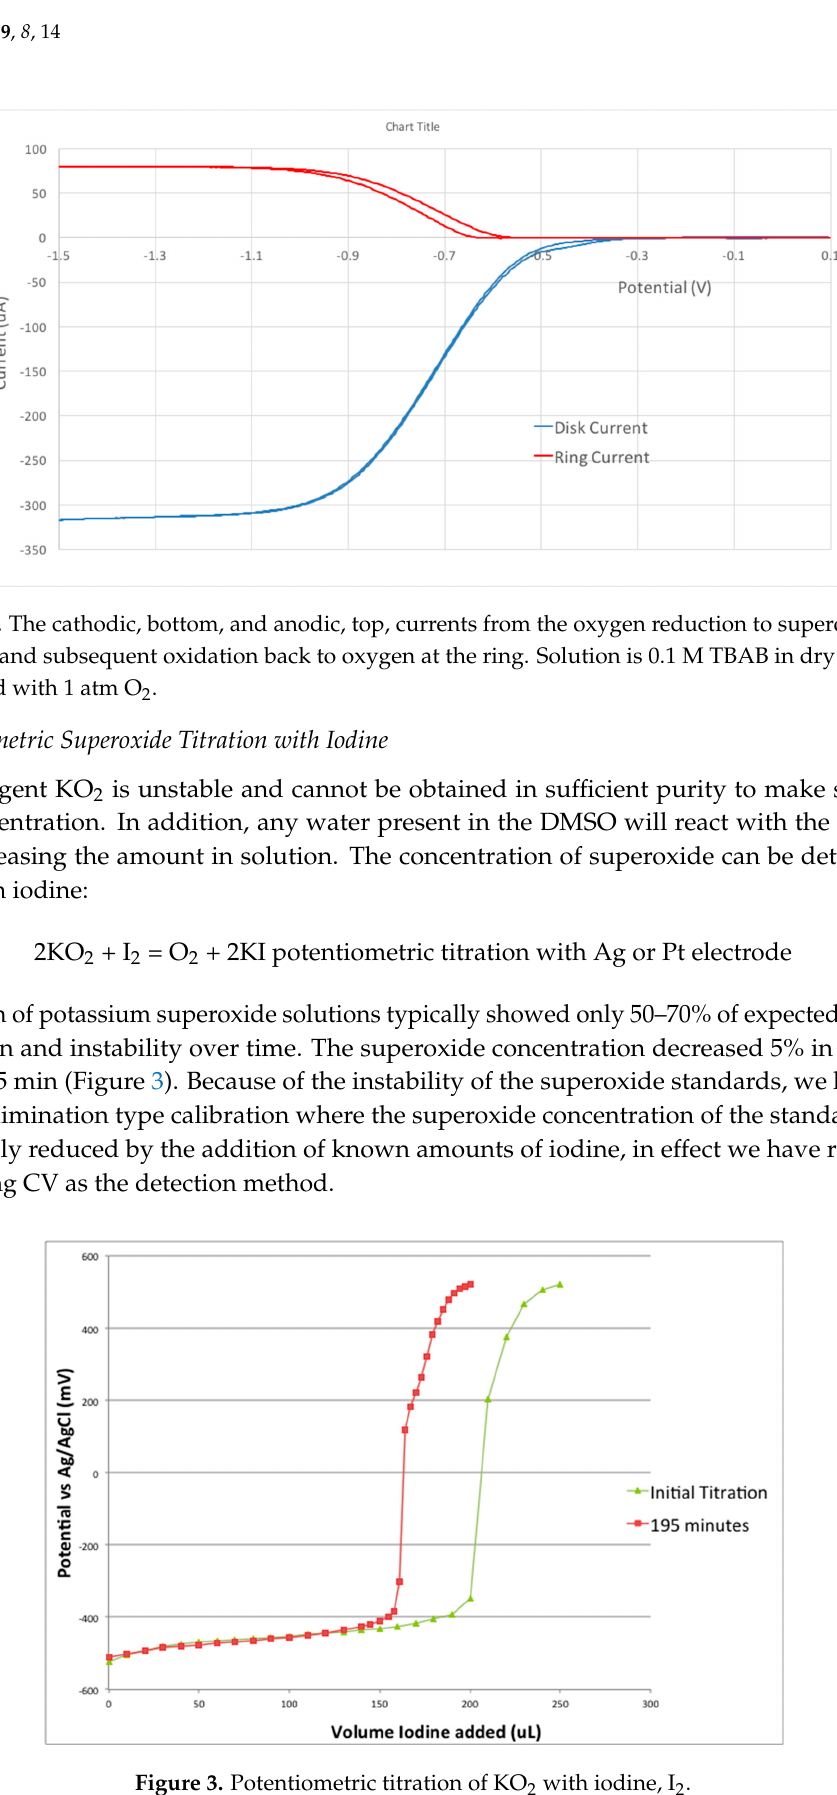
Figure 3. Potentiometric titration of KO 2 with iodine, I 2 .